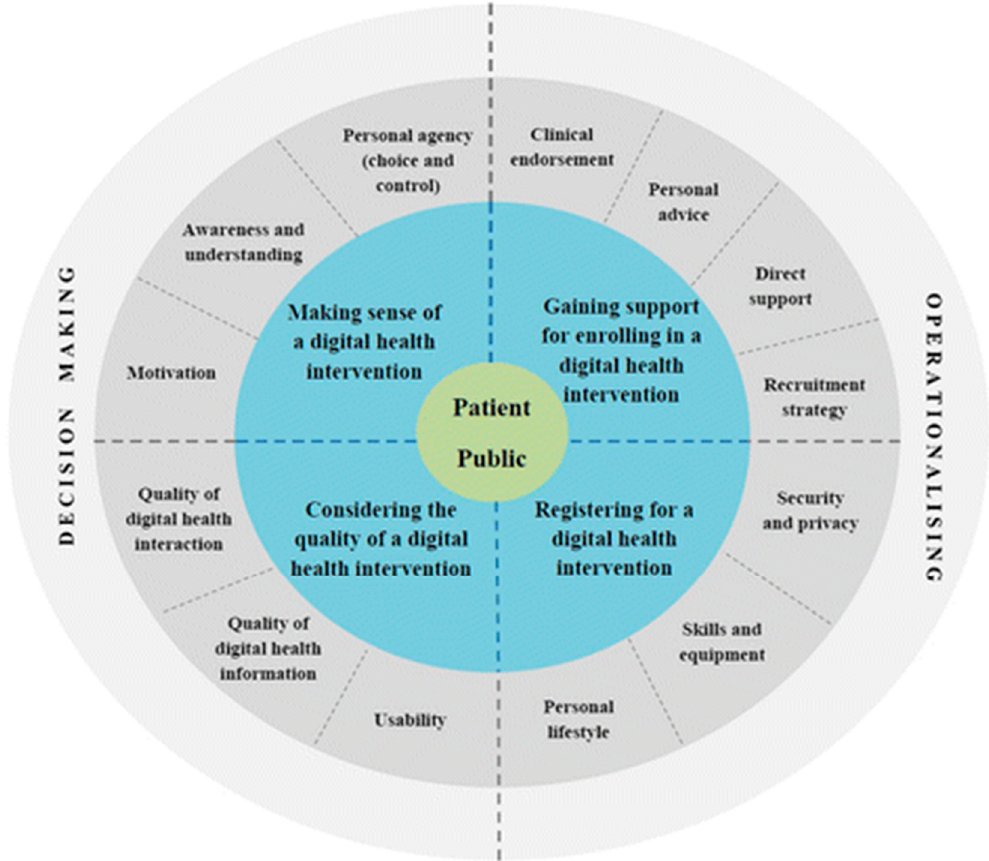
Figure 1. Digital health engagement model (DIEGO).